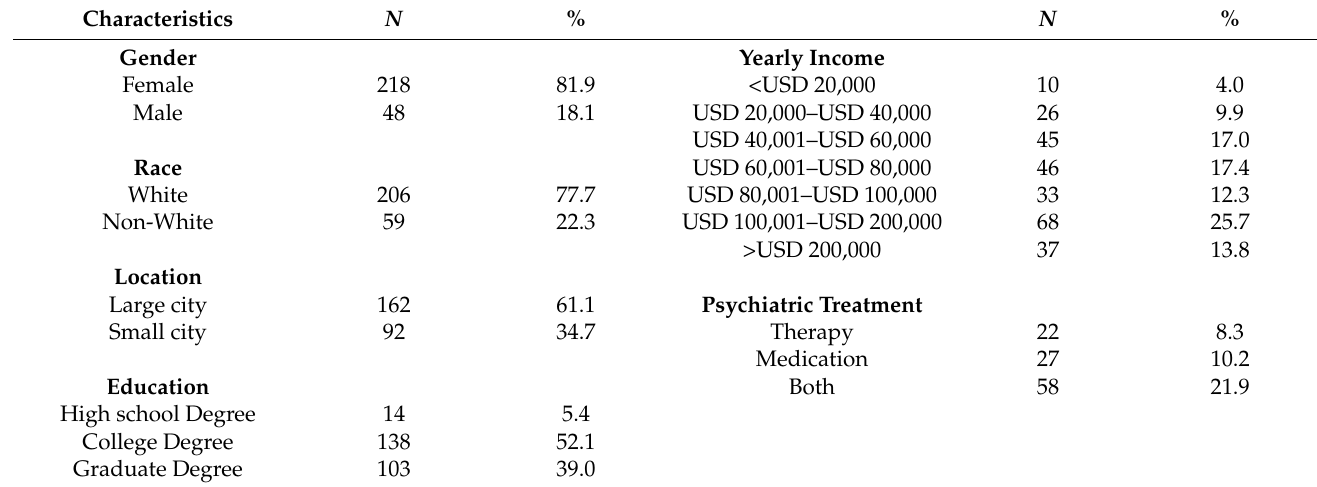
Table 1. Demographic characteristics of healthcare providers